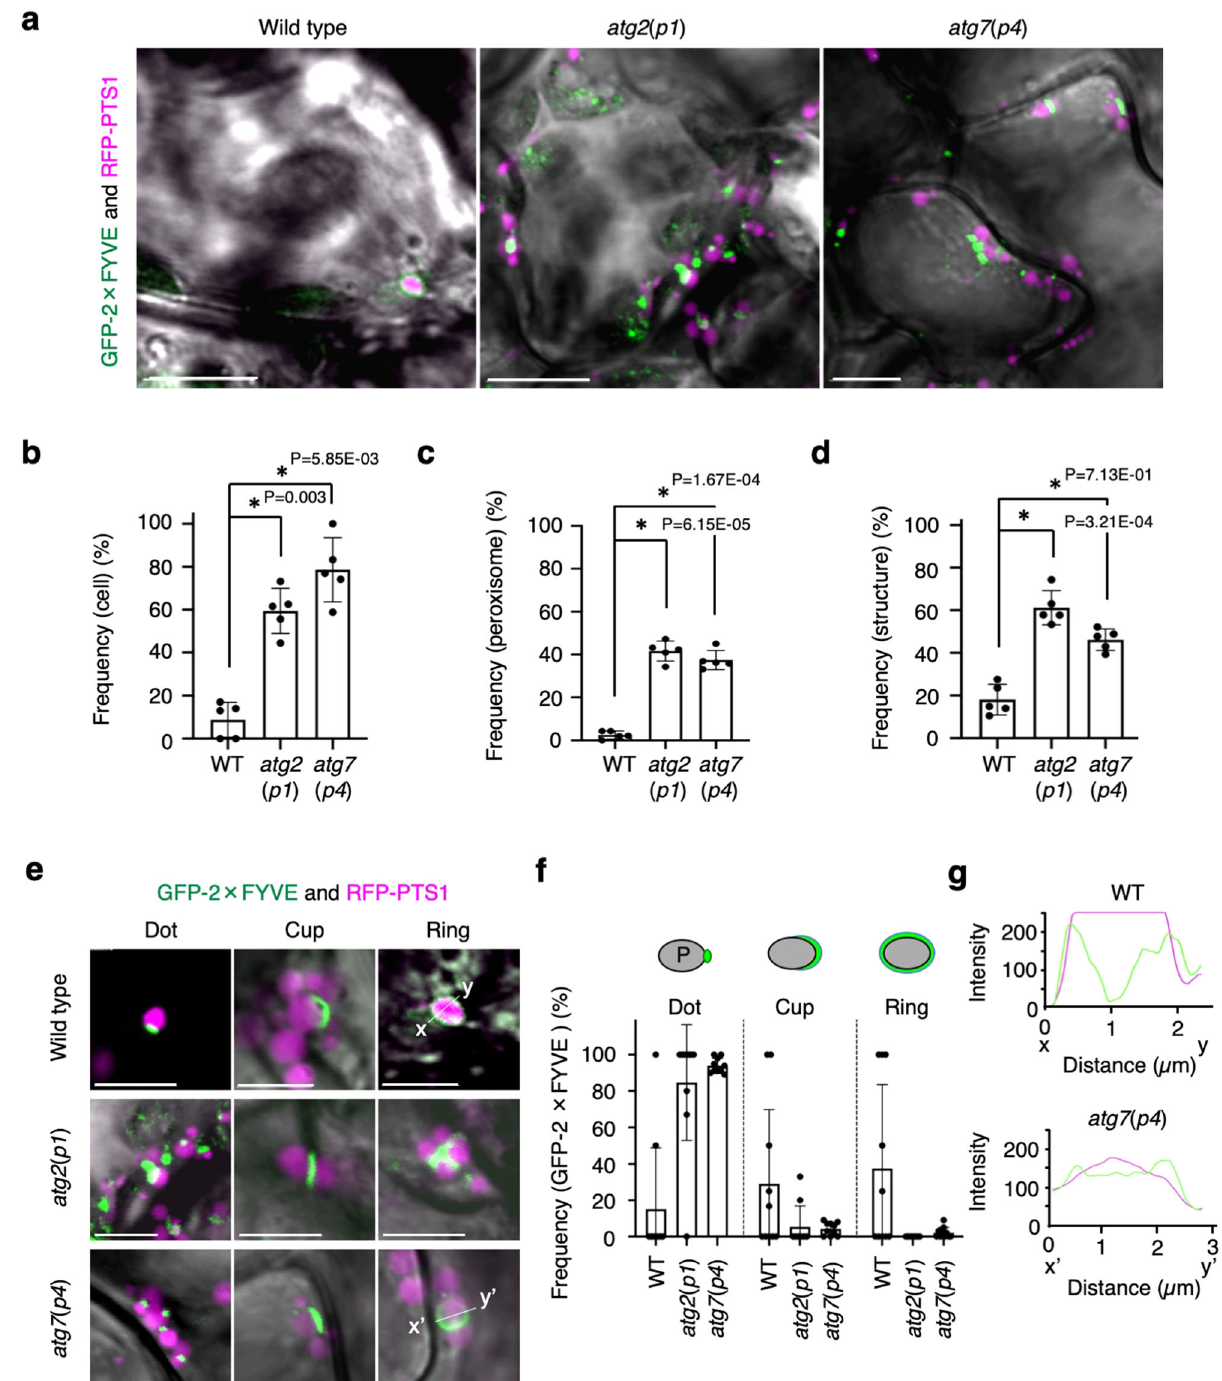
Fig. 3 | GFP-2×FYVE targets peroxisomes. a Confocal microscope images of peroxisomes (RFP-PTS1, magenta) and GFP-2×FYVE (green) in WT, atg2 ( p1 ), and atg7 ( p4 ) leaf mesophyll cells. Images were obtained from the surface to middle depth region of 3-week-old plants cultured on an agar plate containing ½ MS with 1% sucrose under normal-intensity (100 μ molm − 2 s − 1 ) white-light conditions. Scale bars, 10 µ m. b Ratio of the cells containing peroxisomes bound by GFP-2×FYVE to total cells. More than 100 cells were tested. c Ratio of the peroxisomes bound by GFP-2×FYVE to total peroxisomes. d Ratio of GFP-2×FYVE structures bound to peroxisomes to total GFP-2×FYVE structures. More than 250 peroxisomes were